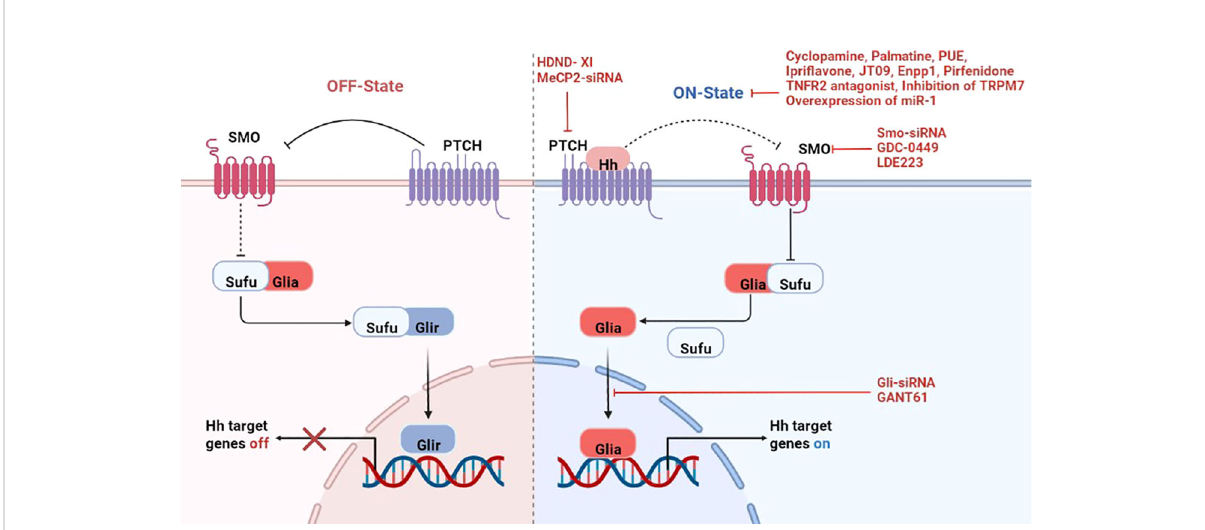
FIGURE 1 A simpli fi ed display of the canonical Hedgehog signaling pathway and treatment of rheumatic diseases by targeting the pathway. Left panel: In the absence of Hh ligands, Ptch suppresses any inactive Smo, leaving Sufu free to bind to Gli activator (Glia), thus repressing it and keeps Hh target genes switch off. Right panel: Binding of Hh ligands to Ptch leading to the dis-inhibition of Smo, which then inhibits Sufu, thereby releasing the nuclear translocation of Glia proteins. Activated Glia in the cytoplasm then translocate into the nucleus and promote transcription of Hh target genes. And there are inhibitors of different genes to suppress the activation of this pathway. Hh-Hedgehog; Ptch-Patched; Smo- Smoothened; Gli-glioma-associated oncogene; Glia-Gli activator; Glir-Gli repressor; Sufu-Suppressed fusion protein; HDND-XI-5-(4- Chlorophenethyl) imino-7-O-acetyl-4-chlorophenethylamine hesperetin; PUE-Phlomis umbrosa extract; Enpp1-Ectonucleotide pyrophosphatase/phosphodiesterase